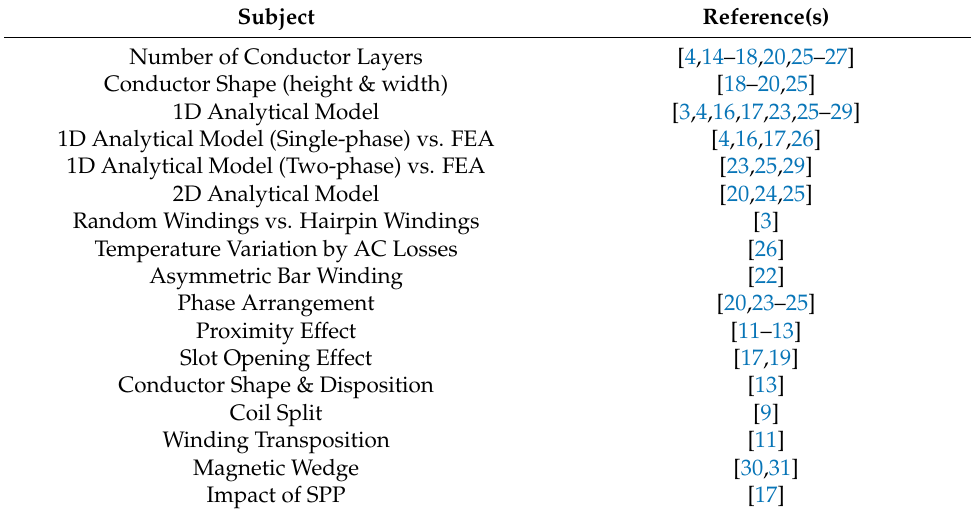
Table 1. Summary of literature review.